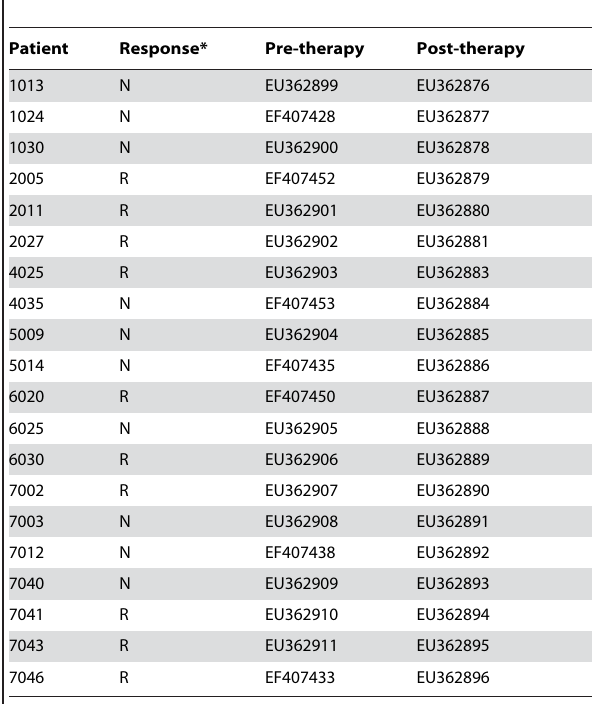
Table 3. Patient numbers, response class, and GenBank accession numbers for pre- and post-therapy